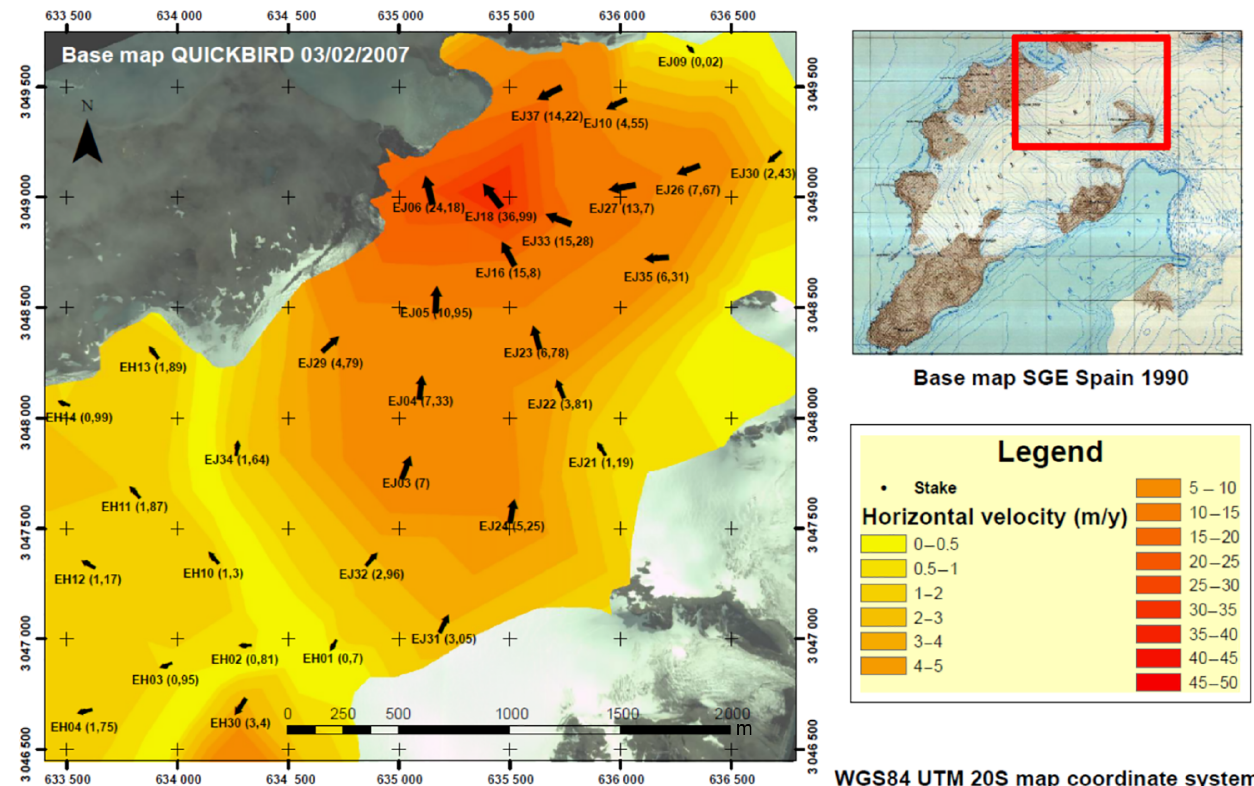
Figure 5. The magnitude of horizontal velocity for Johnsons Glacier, obtained from the spatial interpolation of the corresponding vector velocity field, calculated for 13 February 2013 using the first-degree polynomial derived from the second-degree polynomial adjustment of the stake positions. The numerical values for the absolute value of velocity at each stake (in brackets) and the vector velocity directions (arrows) are also represented. The yellow near-zero velocity band indicates the approximate location of the ice divides (except for the zone to the east, between UTM northing 3048000 and 3048500, which corresponds to a zone of thin ice frozen to the bed on the upper part of a